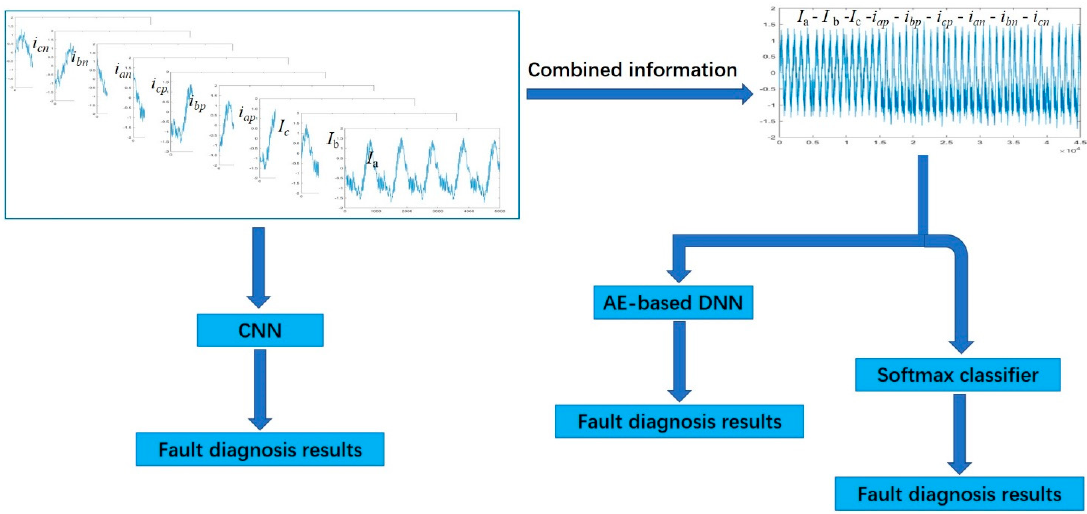
Figure 3. Framework for fault detection and classification for MMC.